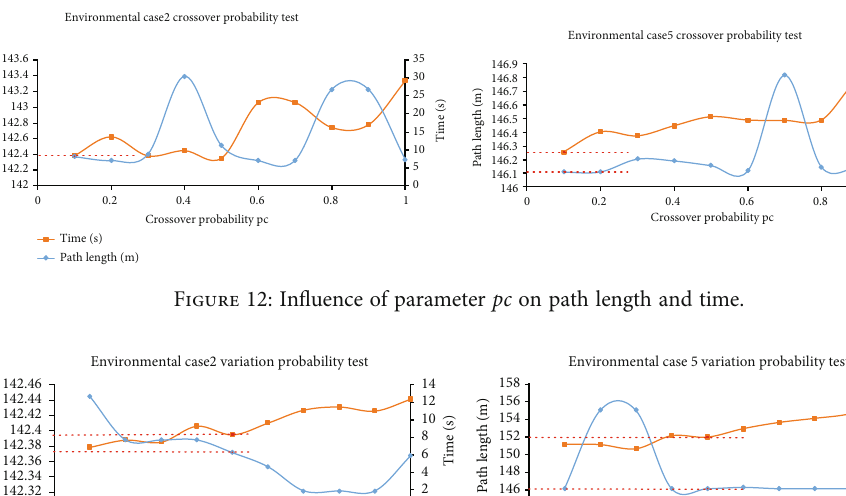
w on path length and time.